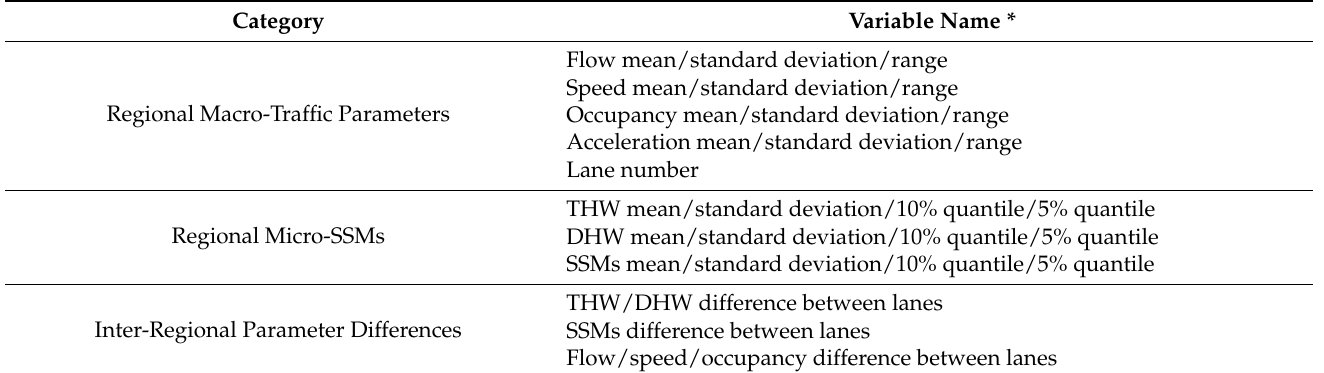
Table 1. Feature variables and their